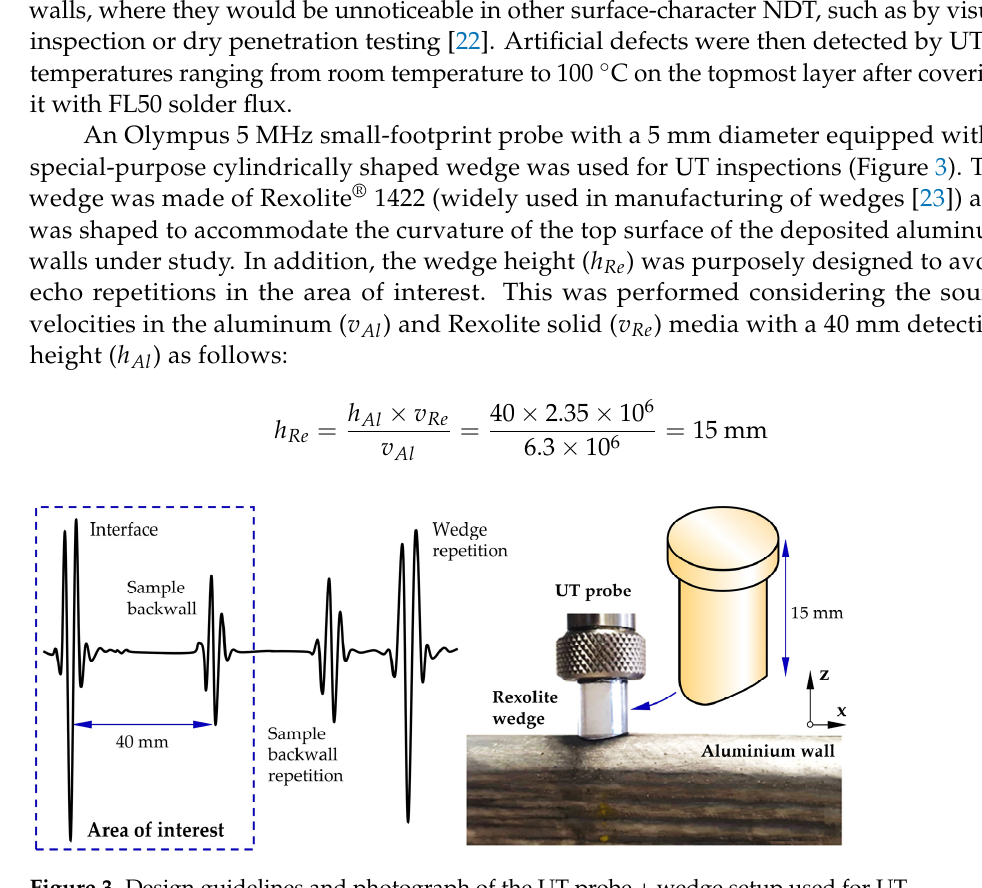
Figure 3. Design guidelines and photograph of the UT probe + wedge setup used for UT.